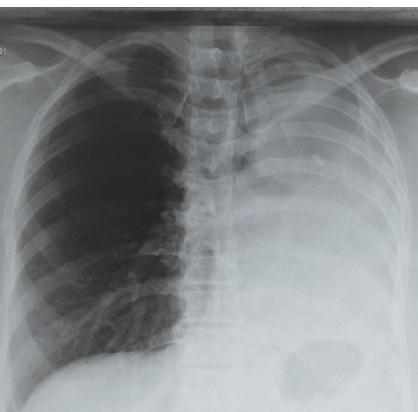
Figure 1: Chest X-ray showed a large opacity of the entire left hemithorax with attraction of the mediastinum element towards the opacity.